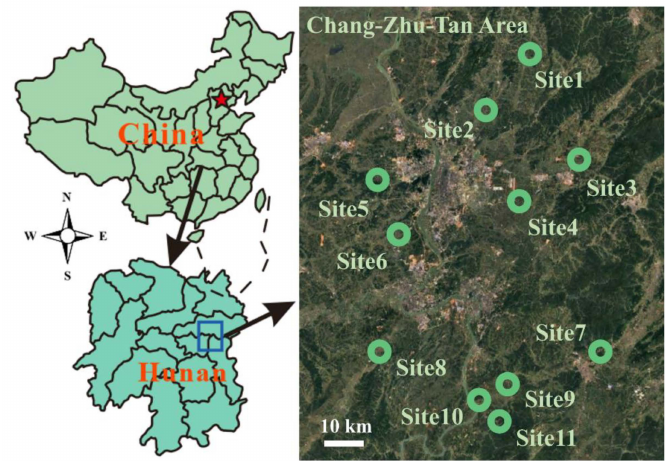
Figure 1. Locations of the sampling points investigated in the